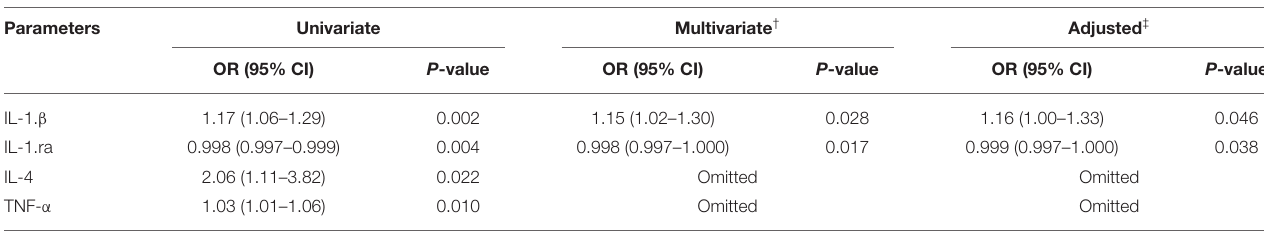
TABLE 2 | The logistic analysis for factors related to the AWE.